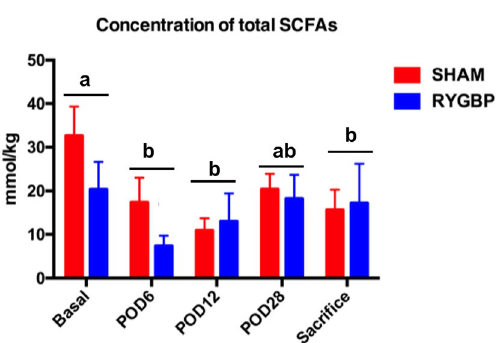
Figure 3. Total concentration of short-chain fatty acids (SCFAs) before surgery (baseline), at postoperative days (PODs) 6, 12 and 28, and at sacrifice (POD 30). RYGBP Roux-en-Y gastric bypass surgery, Sham sham surgery. Time effect: p = 0.002 . There was no effect of type of surgery (sham vs. RYGB) at any time. Different letters indicate a significant statistical difference at p <